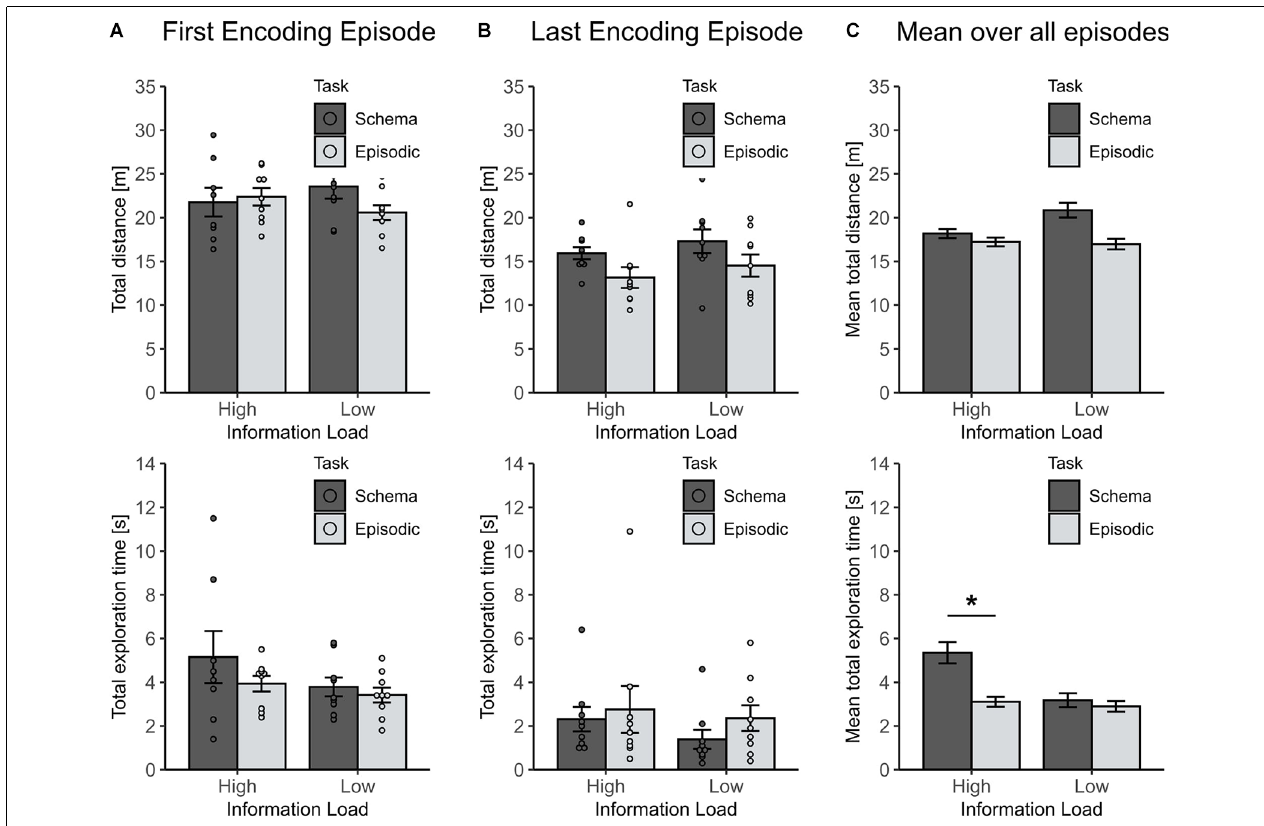
FIGURE 3 | Locomotion parameters for encoding episodes to assess unspecific motivational differences between experimental groups. (A) For the first encoding episode traveled distance and total exploration time were comparable across conditions (all p > 0.1). (B) For the last encoding episode (either the fourth or eighth in the low or high information load condition, respectively) the traveled distance decreased more in the high than in low-information load condition ( p = 0.019), whereas the total exploration time remained comparable across groups ( p > 0.3). (C) Mean distance traveled over all encoding episodes was lower in the high than in the low information load condition ( p = 0.018). Unexpectedly, the mean total exploration time across all episodes depended on an interaction of Information Load and Type of Memory ( p = 0.037) with this effect largely driven by higher mean exploration time in the High Load/Schema condition (lower panel). Statistically controlling for this effect did not change results for retrieval (see text). * p <